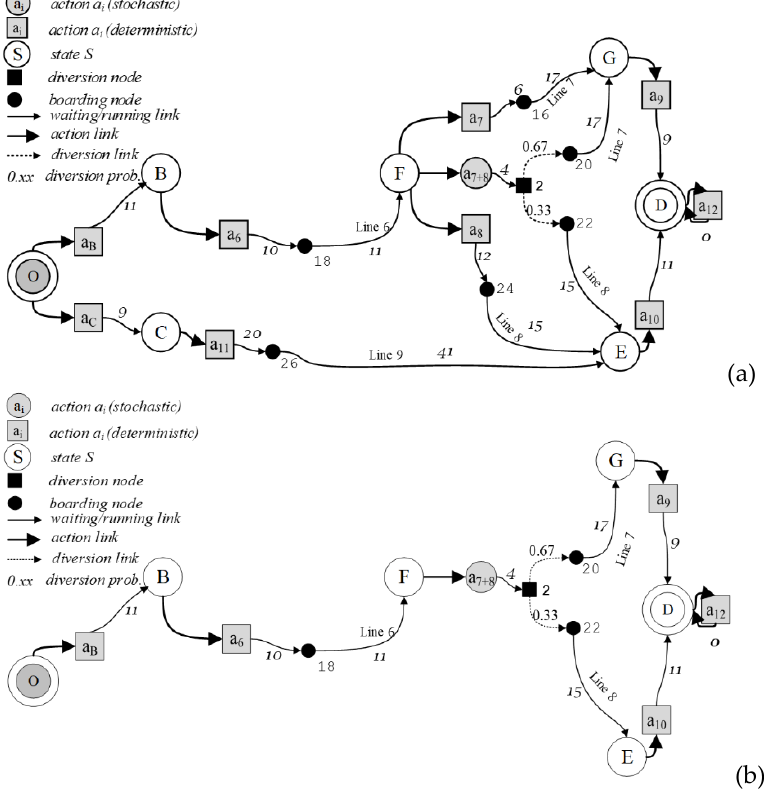
Figure 2. ( a ) Example of state–action trees relative to the network in Figure 1. ( b ) Example of state–action trees relative to the network in Figure 1 with action a B .